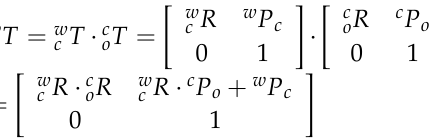
Figure 3. Schematic diagram of the world coordinate system and camera coordinate system conversion.